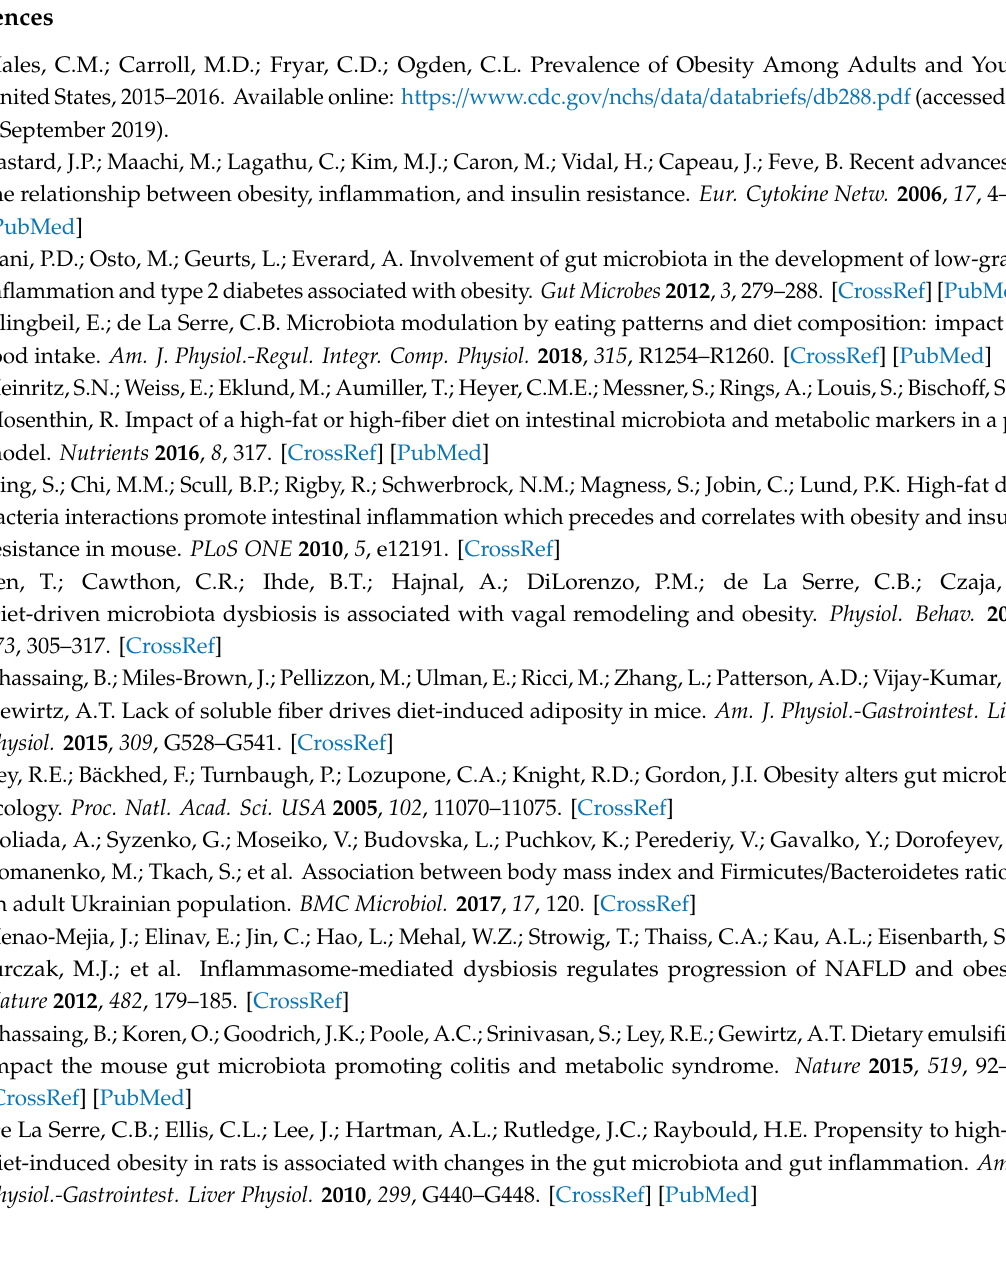
Table S1: Diet composition of HF and HFRS diets; Table S2: Resistant starch in raw potato starch, chow, HF, and HFRS diets; Figure S1: Microbiota abundance by taxonomic